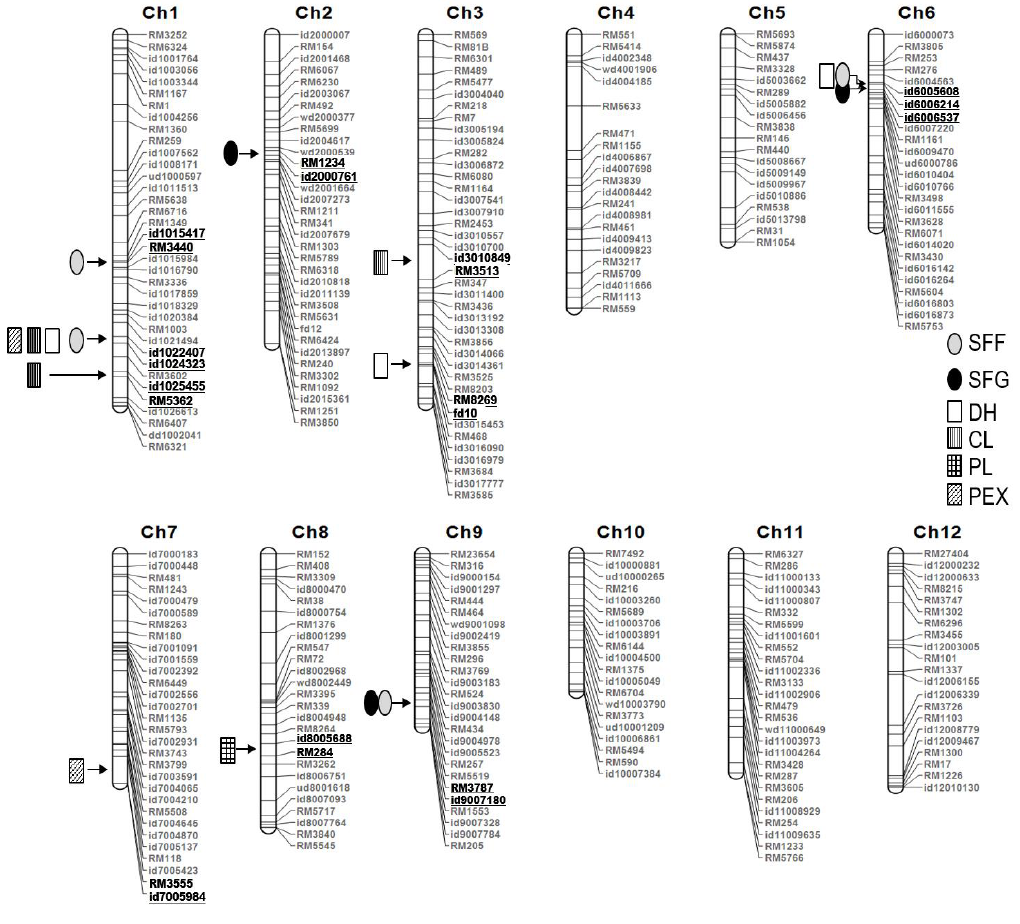
Figure 2. The linkage map and chromosomal locations of quantitative trait loci (QTL) for spikelet fertility and other agronomic traits detected in the recombinant inbred line (RIL) population. QTL detected through composite interval mapping analysis (IciMapping v3.2) are represented as boxes to the left of the chromosomes. Trait abbreviations are as follows. SFF: spikelet fertility in the cold-water-irrigated field; SFG: spikelet fertility in the temperature-controlled greenhouse; DH: days to heading; CL: culm length; PL: panicle length; PEX: panicle exsertion.